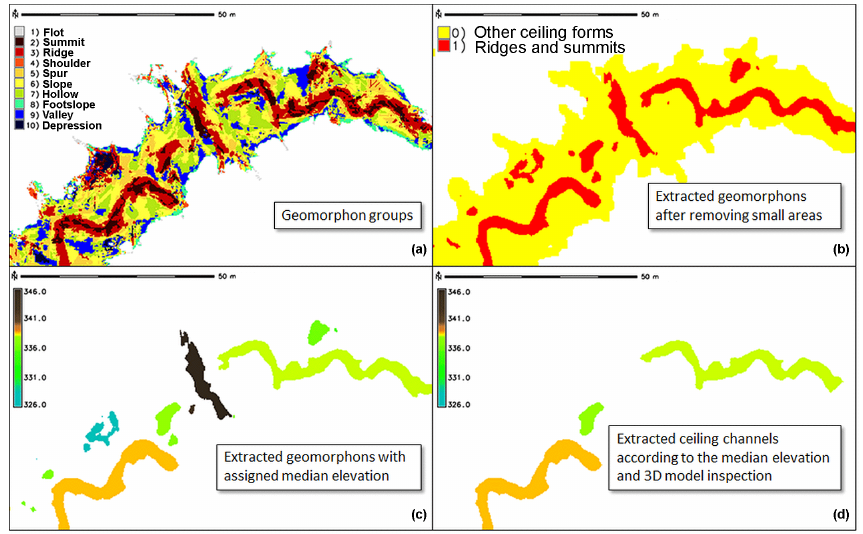
Figure 9. Classification of the ceiling surface (DEM_CH) of the Majko’s Dome and the Gothic Dome (Fig. 3) in GRASS GIS to extract the ceiling channels as landforms. Ceiling channels are classified with the r.geomorphons module as ridges and some parts as summits (a) . The two categories are extracted as binary rasters with r.mapcalc and small clusters are removed with r.neighbors (b) . The areas are clumped into individual spatial units for which elevation summary statistics were calculated. Median elevation (c) most appropriately separated the ceiling channels from other ridges and summits (d)